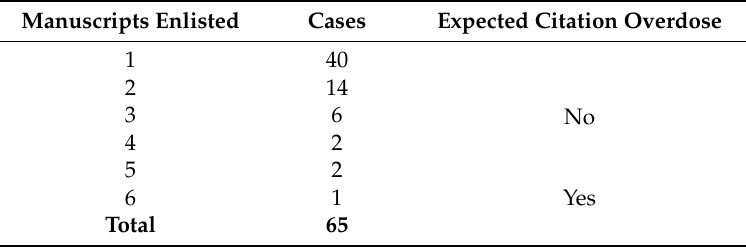
Table 2. Number of Author1’s manuscripts enlisted within the second question (Q2). Manuscripts Enlisted Cases